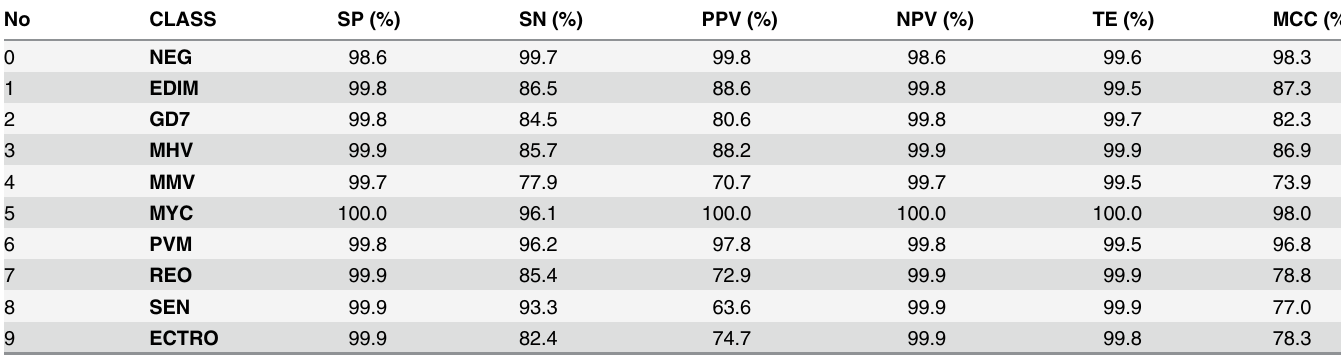
Table 2. Performance of the “ Training Data Set ” using the classi fi cation algorithm